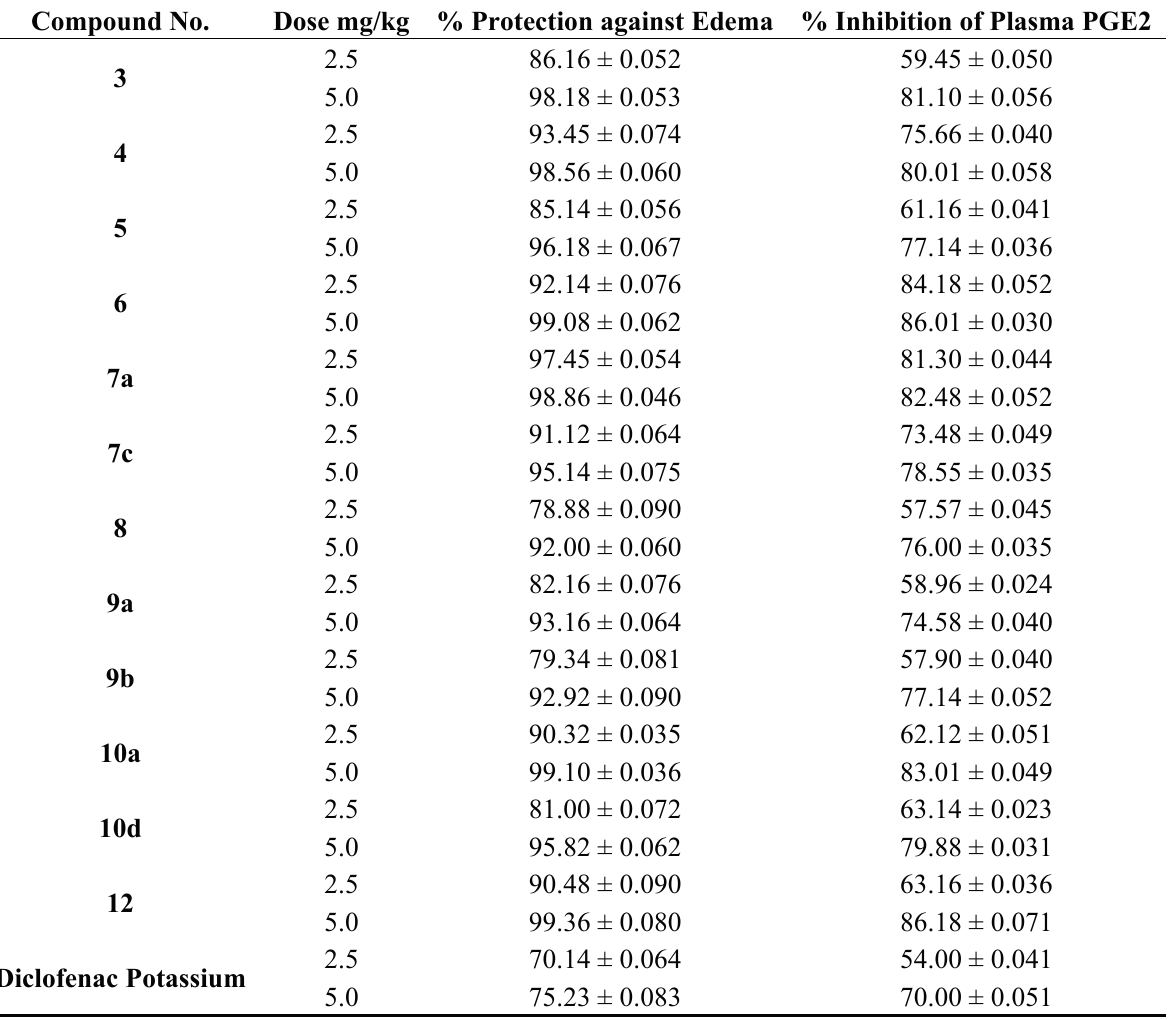
Table 2. Anti-inflammatory activities of some new synthesized